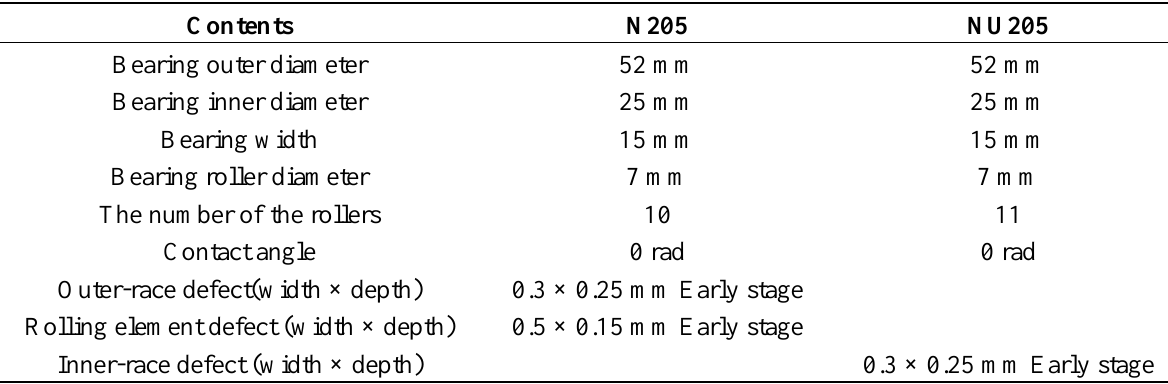
Table 1. Bearing information for